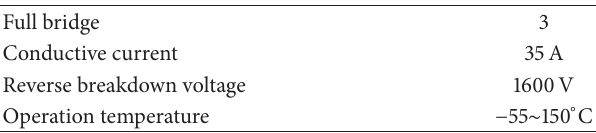
Table 3: Rectifier parameter.